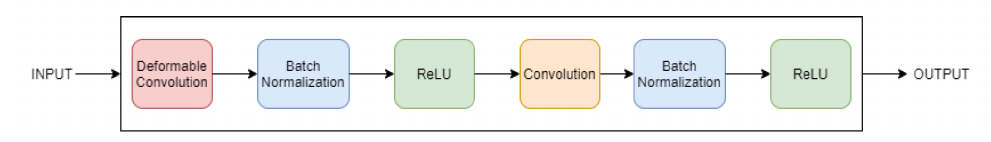
Figure 3. Proposed module based on ASPP and Adaptive Context Encoding